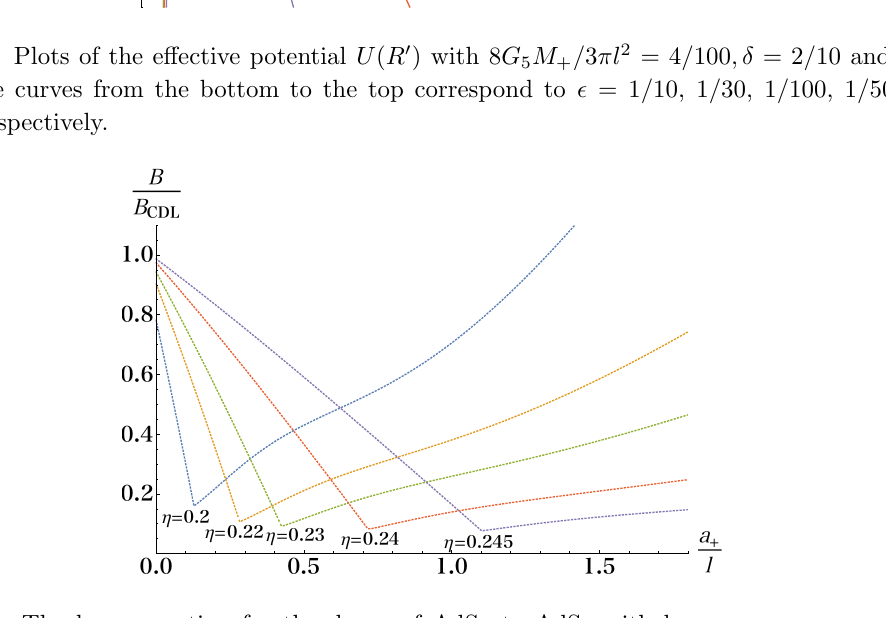
Figure 6 . The bounce action for the decay of AdS 5 to AdS 5 with lower vacuum energy with (cid:17) = 0 : 2, 0 : 22, 0 : 23, 0 : 24 and 0 : 245. We chose (cid:14) = 6 = 10, 8 G 5 M + = 3 (cid:25)l 2 = 4 = 100. order energy density. As an illustration, we show numerical results for the bounce action for the parameters (cid:14) = 6 = 10 and 8 G a , the bubbles without remnants ( M + the bounce becomes small until the critical value above which a remnant remains. As